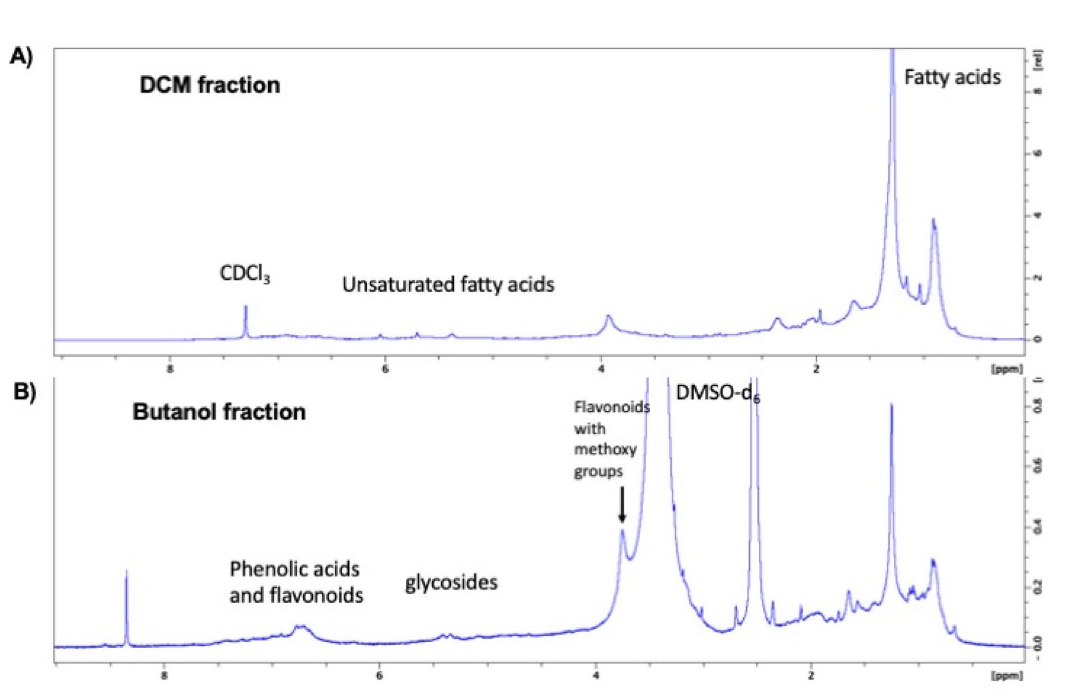
Figure 5. 1 H NMR (400 MHz) analysis of the DCM fraction in CDCl 3 ( A ) and the butanol fractions in DMSO-d 6 ( B ) of sugarcane leaf